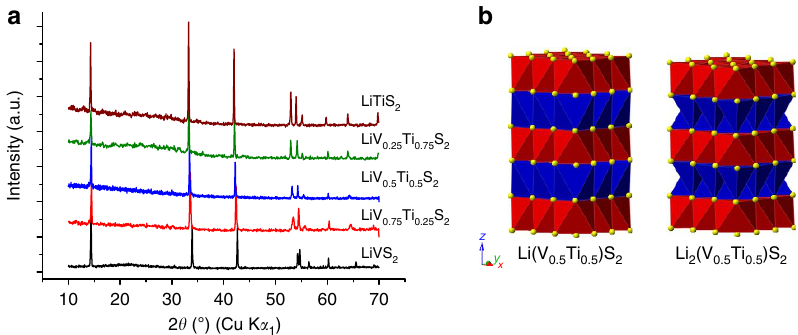
Figure 1 | Structures of Li(V 1- x Ti x )S 2 and Li 2 (V 0.5 Ti 0.5 )S 2 . ( a ) Powder X-ray diffraction patterns of as-prepared Li(V 1- x Ti x )S 2 . ( b ) Crystal structures of Li(V 0.5 Ti 0.5 )S 2 and Li 2 (V 0.5 Ti 0.5 )S 2 . Red octahedra—MS 6 , blue polyhedra—LiS x and yellow